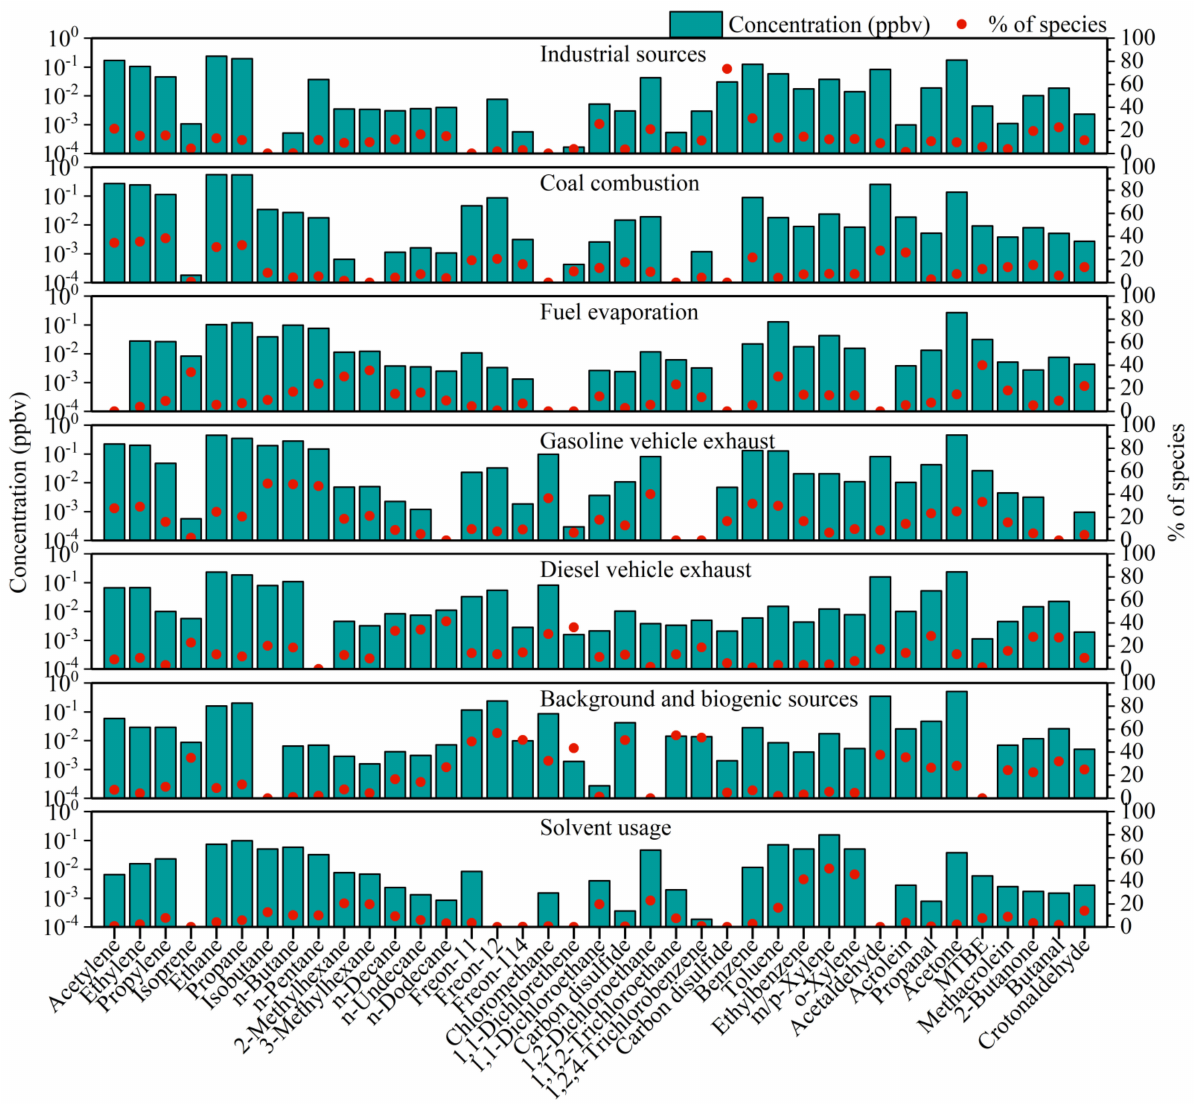
Figure 4. Source profiles of the resolved factors from the positive matrix factorization (PMF)